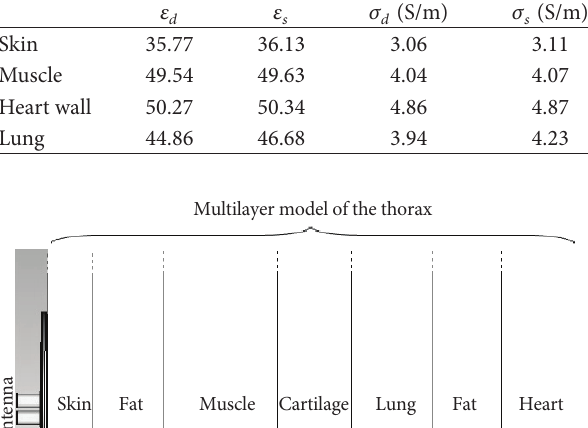
T 2: Tissues electrical parameters at the end of diastole ( ) and at the end of systole ( 𝜎𝜎 𝑑𝑑